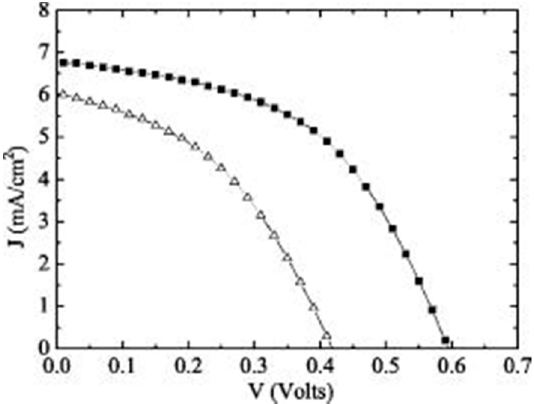
Figure 4. Current density-voltage characteristics of Au/Cu 2 O/ZnO/ITO/MgF 2 device (upper) and Au/Cu 2 O/ZnO/MgF 2 device (lower) under AM 1.5G illumination Reprinted from Applied Physics Letters 88, 163502 (2006) with the permission of AIP Publishing [29].